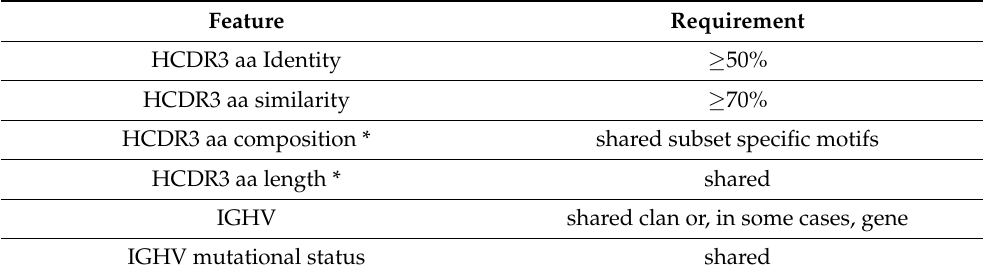
Table 1. General requirements for two CLL BcRs to be considered to belong to the same stereo- typed subset. Feature Requirement HCDR3 aa